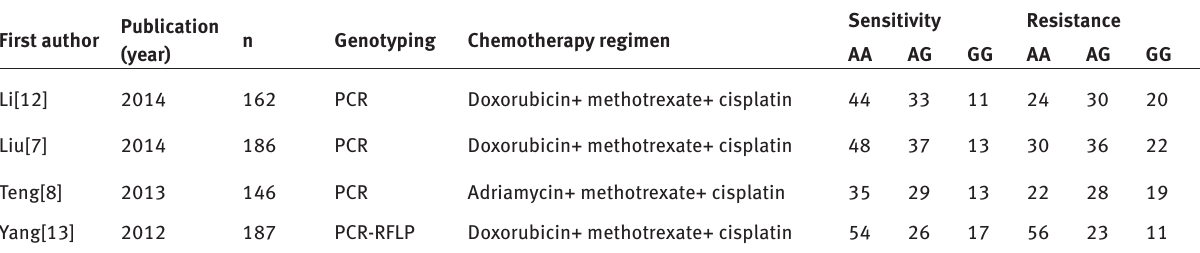
Table 1: General information of the included 4 studies Publication First author